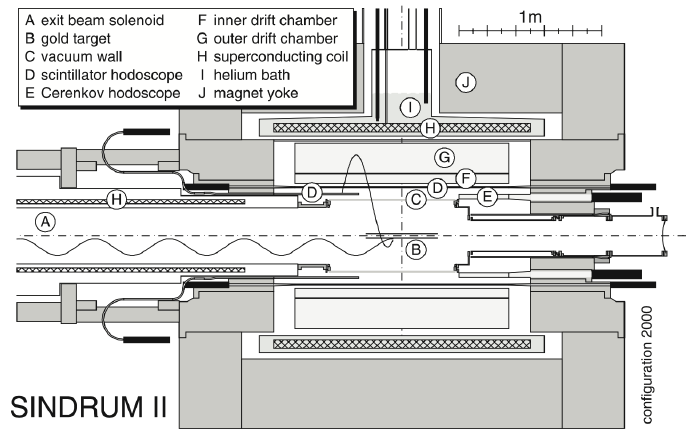
Figure 17. The SINDRUM-II experimental setup. Figure from [138].